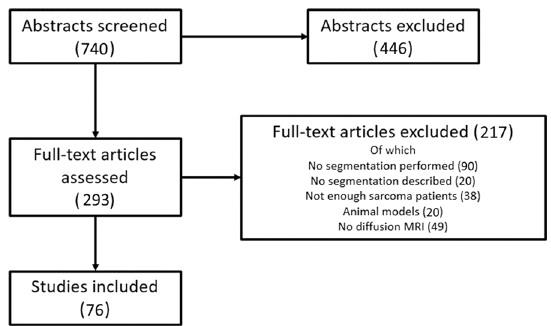
Fig. 1 From the 740 studies in the search, 446 were excluded based on the title or abstract. Articles were excluded if they did not mention or imply MRI and segmentation of a sarcoma. Next, out of the 293 remaining articles, 217 were excluded based on the full text. Articles were excluded if no DWI was performed, if no details on segmentation were present, or if MRI was only performed on animals. Additionally, articles were excluded if they included less than 10 sarcoma patients and those patients constituted less than 50% of